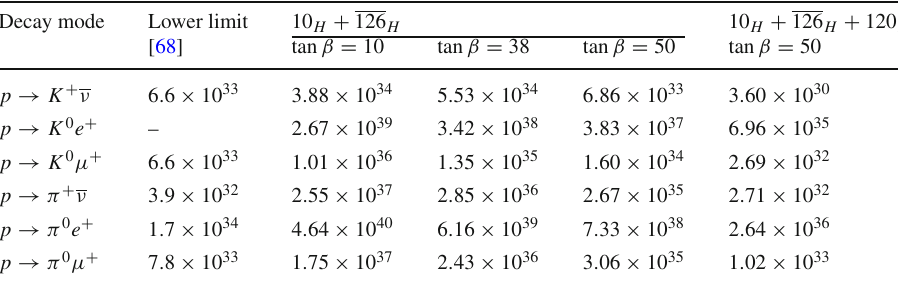
Decay mode Lower limit 10 H + 126 H